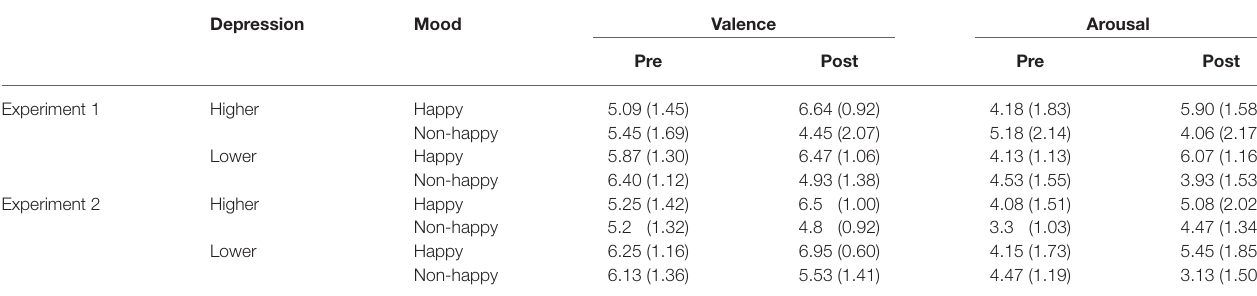
TABLE 1 | Mean mood rating values of pre and post-test in Experiments 1 and 2.